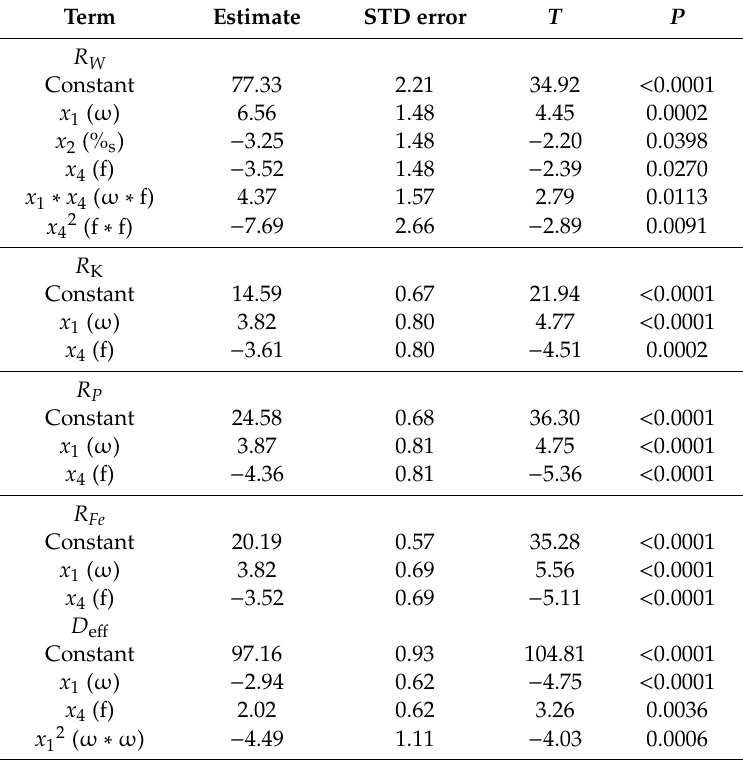
Table 8. Parameter estimates for the final models for the Falcon SB as a function of the